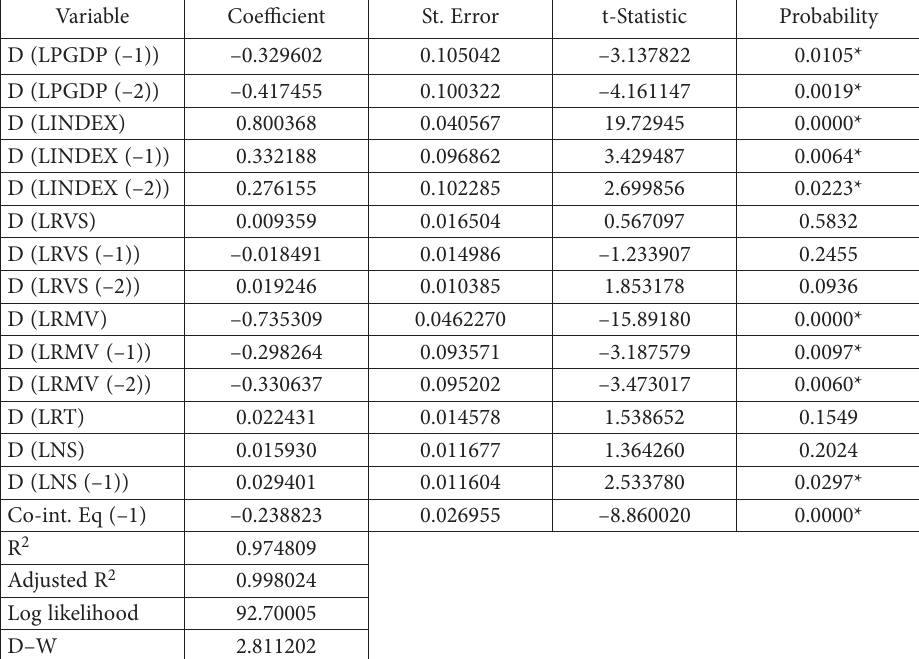
Table 7. The ARDL ECM with dependent variable D(LPGDP) Variable Coefficient St. Error t-Statistic